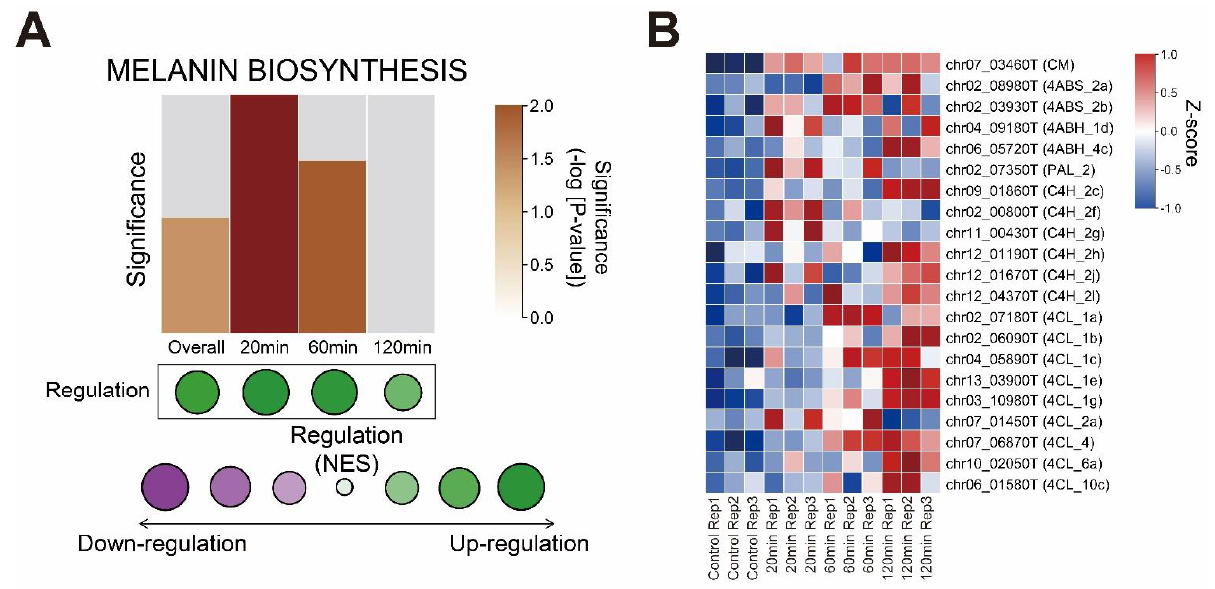
Figure 4. Melanin biosynthesis genes were up-regulated in response to mechanical stimulus. ( A ) Summary of gene set enrichment analysis (GSEA) of melanin biosynthesis pathway proposed in A. bisporus. GSEA analysis was performed in comparison with 0 min samples with indicated sample conditions. Bar graph indicates relative significance of enrichment in each condition; higher bar with deeper brown color indicates significant enrichment. Regulation patterns of melanin biosynthesis genes are indicated as colored dots. Green dots indicate up-regulation in each condition, while pur- ple dots indicate down-regulation. Bigger dots indicate regulation was even significant in each con- dition. Melanin biosynthesis genes are indicated in Figure S5. ( B ) Heatmap of leading-edge genes identified in GSEA analysis. CM; chorismate mutase, 4ABS; 4-aminobenzoate synthase, 4ABH; 4- aminobenzoate hydroxylase, GGT; γ -glutaminyltransferase, PDHtase; prephenate dehydratase, PDH; prephenate dehydrogenase, AT; (4-hydroxy) phenylpyruvate aminotransferase, PPO; poly- phenoloxidase (tyrosinase), PAL; phenylalanine ammonialyase, C4H; Trans-cinnamate-4-monoox- ygenase, 4CL; 4-coumarate CoA ligase, GHB; γ - L -glutaminyl-4-hydroxybenzene, PAP; p -aminophe- nol, DOPA; 3,4-dihydroxyphenylalanine. Figure 5. Proposed transcriptomic response after mechanical stimulus in A. bisporus .